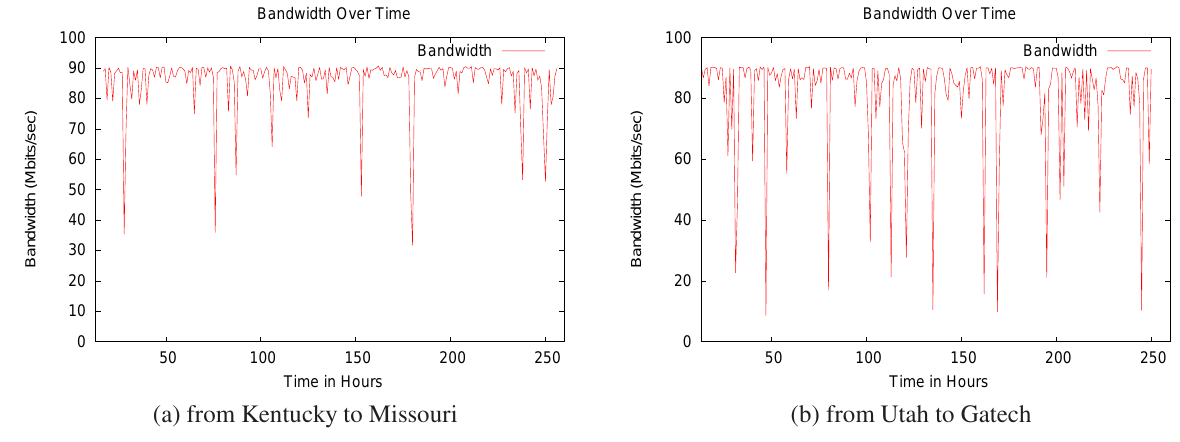
Figure 8. Bandwidth of the links connecting two VMs from two different aggregates The pdfs in Figure 10(a) and (b) demonstrate a different However, it is still relatively concentrated, as shown in pattern than those in Figure 9(a) and (b). About 20% of the Figure 9(b). The bandwidth for the links connecting VMs from different aggregates is distributed in a much wider range. values are not so close to the average